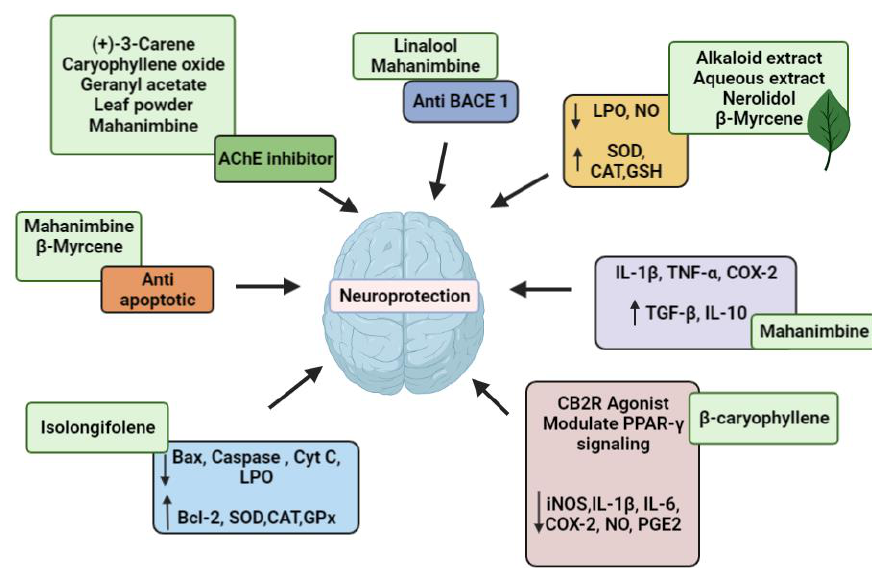
Figure 2. Mechanisms of action of the identified bioactive compounds from Murraya koenigii .